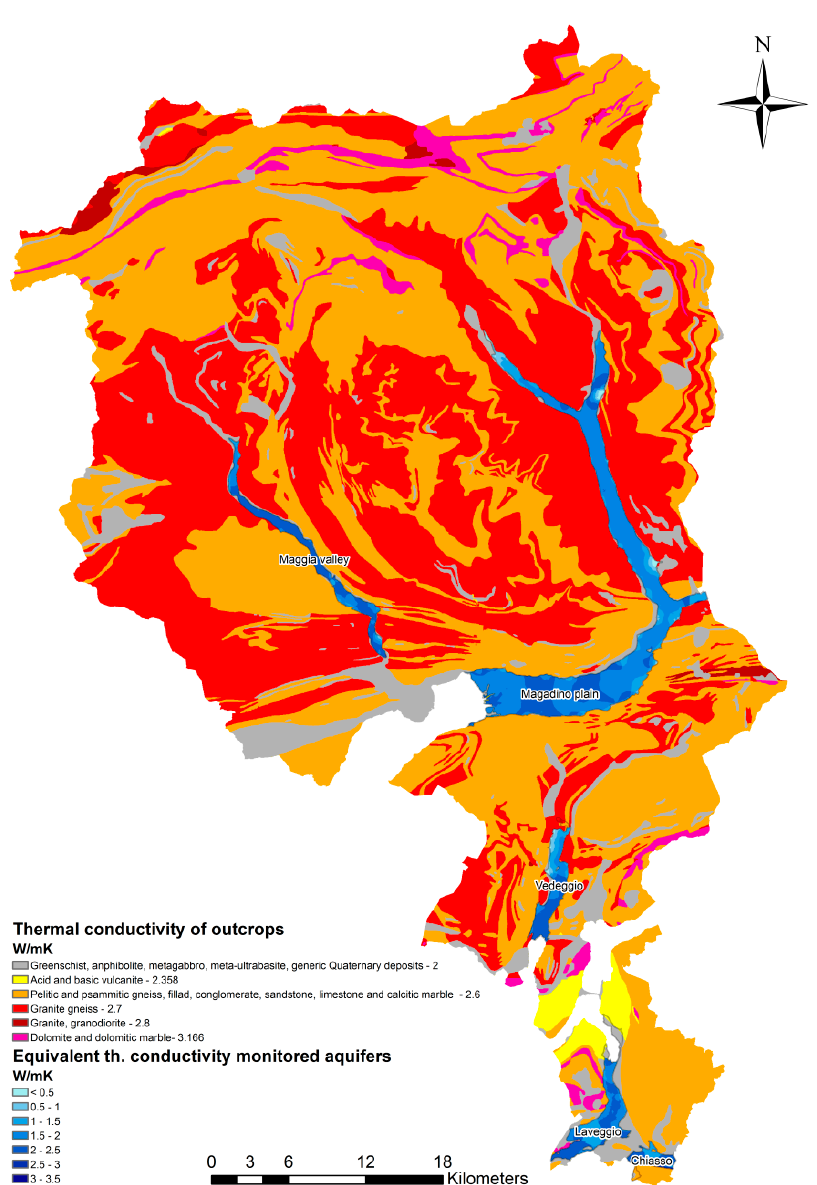
Figure 4. Spatial reconstruction of Cantone Ticino thermal conductivity: red shades belong to outcrops of different lithologies, while blue shades represent monitored aquifers. The names of the monitored aquifers are reported in the map.